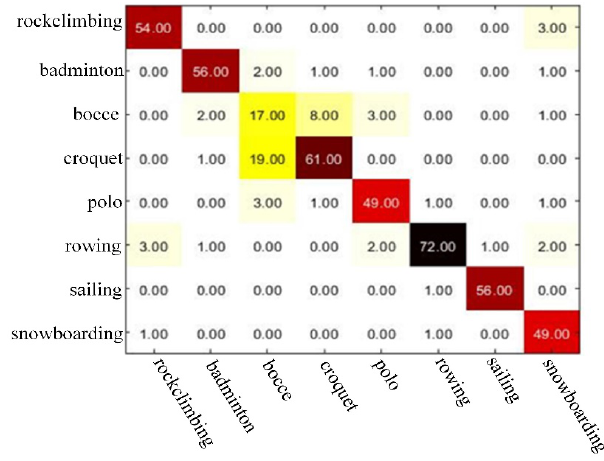
Figure 9. The visual predicted matrix of UIUC Sports.